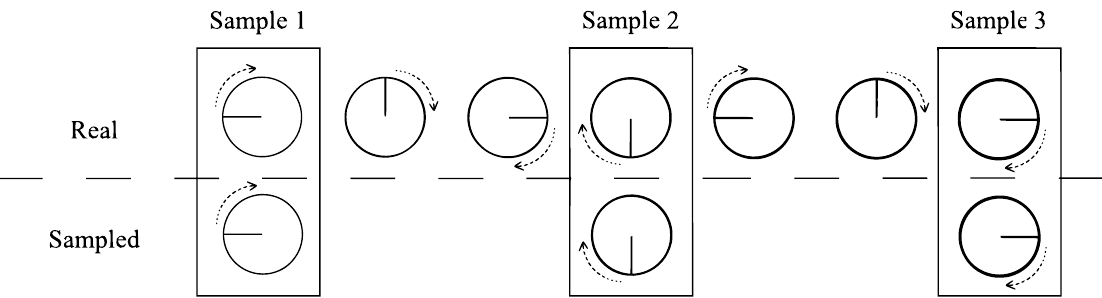
Figure 1. Aliasing wheel. Example of an aliasing effect in the clockwise rotation of a wheel. The visualized behavior on film is a counter-clockwise rotation, known as the wagon-wheel effect. The long time interval between samples explains this